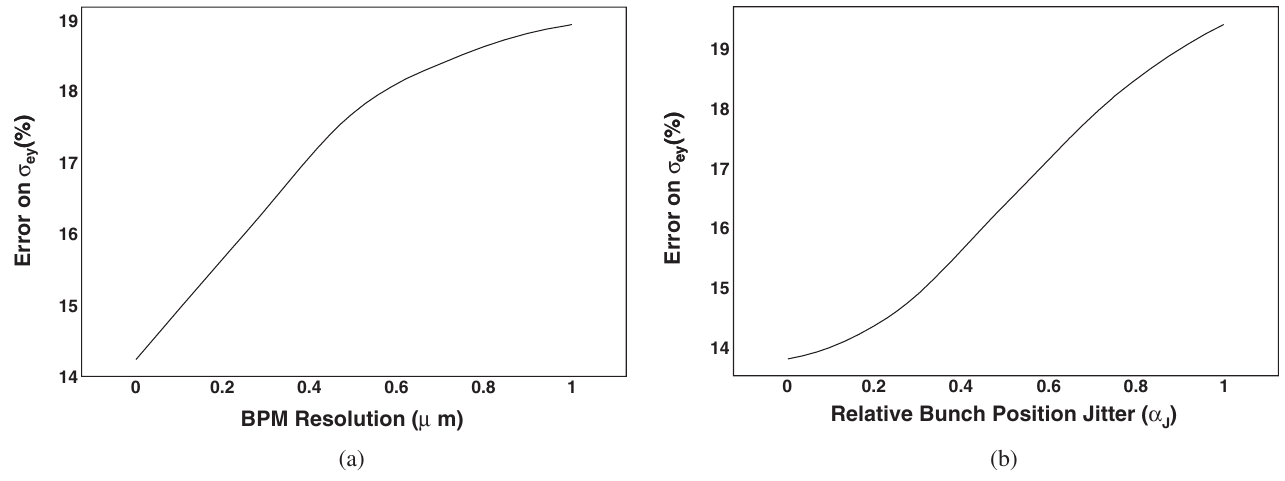
FIG. 16. Percentage errors obtained by inverting Eq. (A2) on a bunch-by-bunch basis for electron-bunch transverse dimensions (cid:1) 1 (cid:3) m , (cid:2) (cid:1) 10 (cid:3) m , laser wavelength (cid:1) 532 nm , M 2 (cid:1) 1 : 3 , f - num (cid:1) 1 : 5 , P (cid:2) ey ex resolution (in (cid:3) m ) with the relative beam jitter fixed at (cid:10) fixed at 0 : 1 (cid:3) m